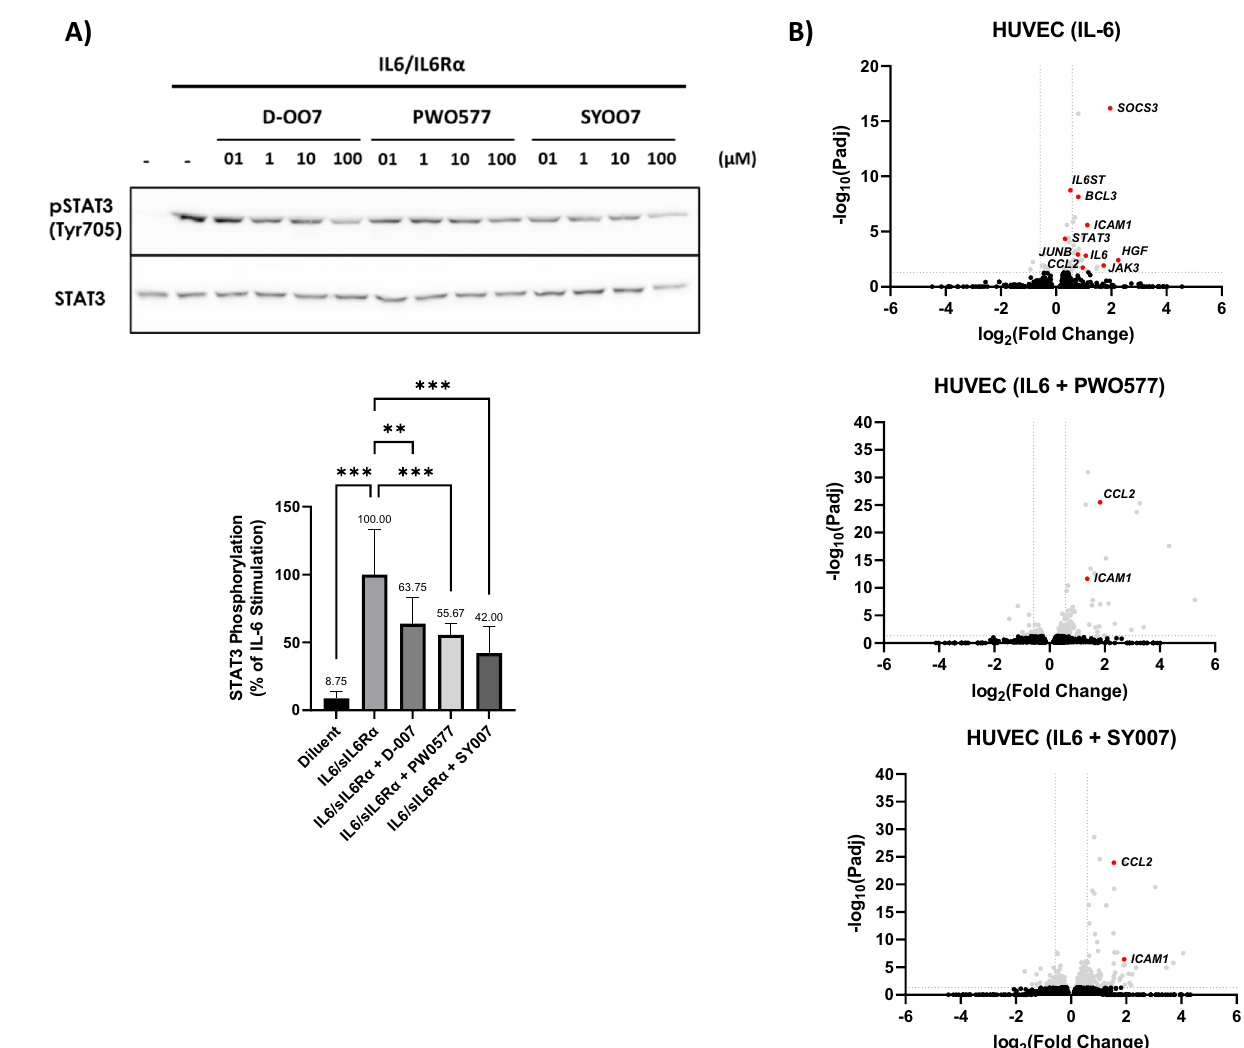
Figure 7. Impact of PWO577 and SY007 on IL-6 Signalling in HUVECs. ( A ) HUVECs were stimulated for the indicated times with IL-6 (5 ng/ml) plus sIL-6Rα (25 ng/ml) in the presence or absence of the indicated concentrations or D-007, PWO577 or SY007. Cell extracts were then immunoblotted with antibodies to pSTAT3 (Tyr705) or total STAT3. Densitometric values from 3 separate immunoblots, at 100 μM ligand concertation, are shown in the bar graph in the lower panel with significant changes STAT3 phosphorylation, relative to cells stimulated with IL-6/sIL-6Rα alone, being indicated: **p < 0.01 and ***p < 0.01 (n = 3). ( B ) HUVECs were stimulated with IL-6/sIL-6Rα, as described above, in the presence or absence of either PWO577 or SY007, as indicated. RNAseq was then performed, as described in “Materials and methods”, and the resulting gene expression changes shown as volcano plots. Significant gene changes (p < 0.05) are shown in light grey whereas non-significant gene changes are shown in black. Significant changes in gene induction associated with IL-6 signalling are shown in